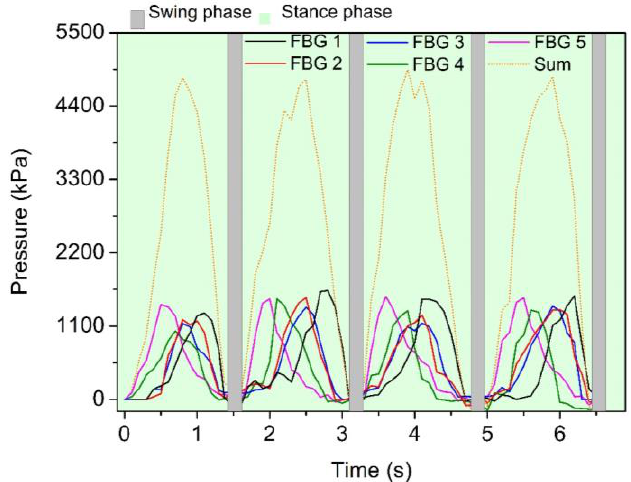
Figure 7. Pressure registered in the cork insole-sensing network for four gait cycles.